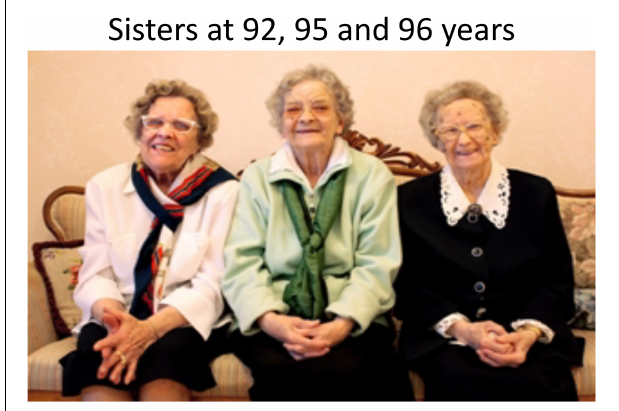
FIGURE 2 | Hilkka, 95, Maija 93 , Pulmu, 91 years of age. Three Finnish Nonagenarian Sibling Sisters-photograph by